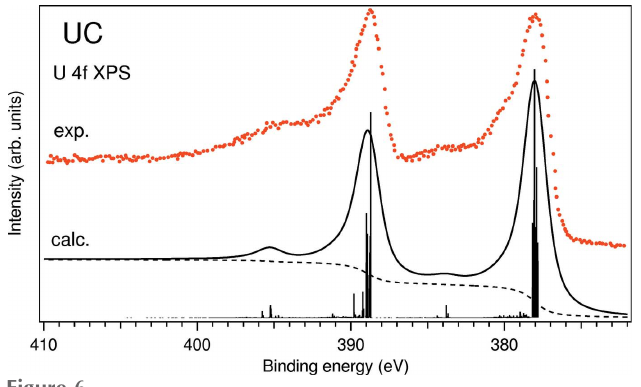
Figure 6 Calculated and measured (Ejima et al. , 1993) U 4 f XPS spectra of